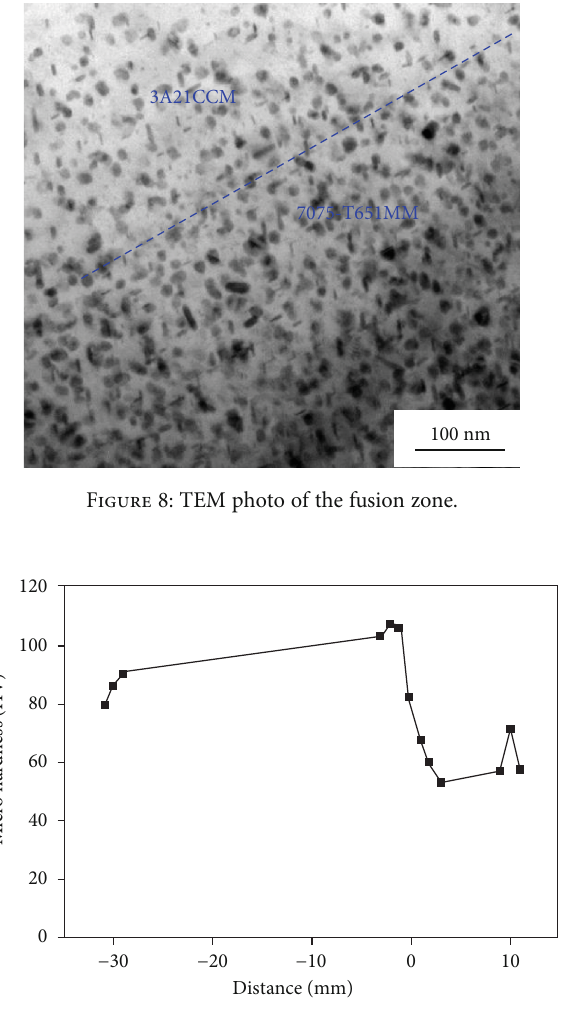
Figure 9: Microhardness test result of the 3A21/7075 aluminum alloy cladding